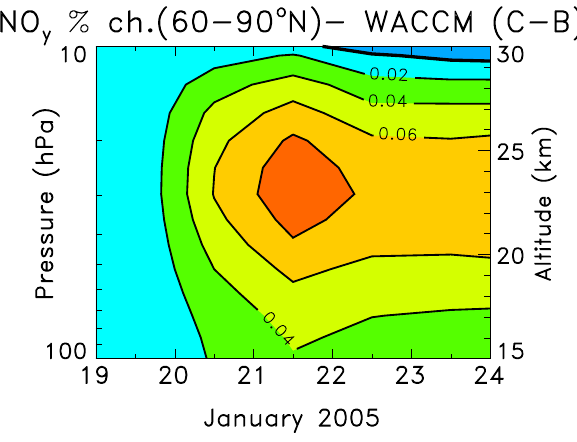
Fig. 14. Daily averaged WACCM3 prediction of the polar Northern Hemisphere (60–90 ◦ N) NO y percentage enhancement due to the GLE (the average of the C realizations minus the average of the B realizations). The contour intervals are 0.0, 0.02, 0.04, 0.06, and